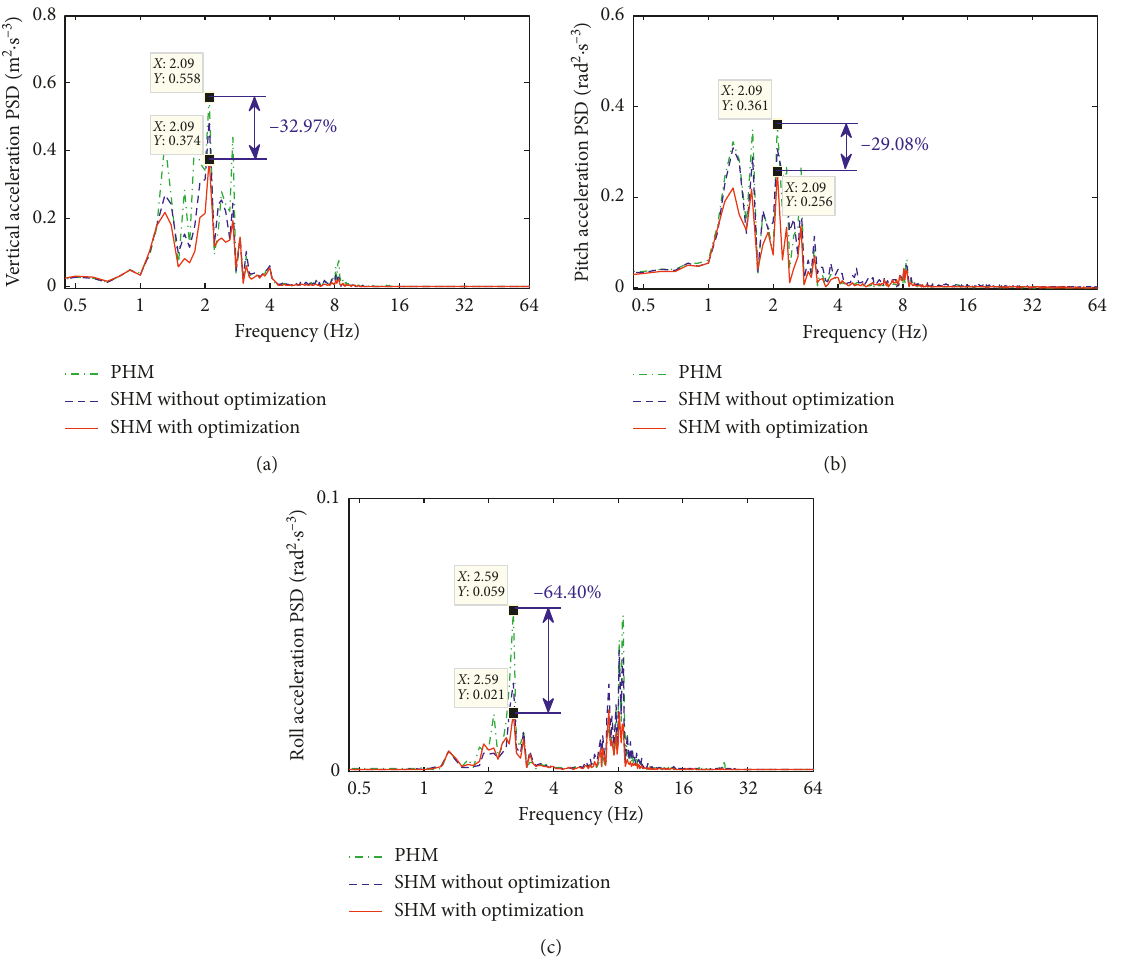
Figure 8: Results of the PSD acceleration responses on the deformable terrain. (a) Vertical driver’s seat. (b) Cab’s pitch angle. (c) Cab’s roll